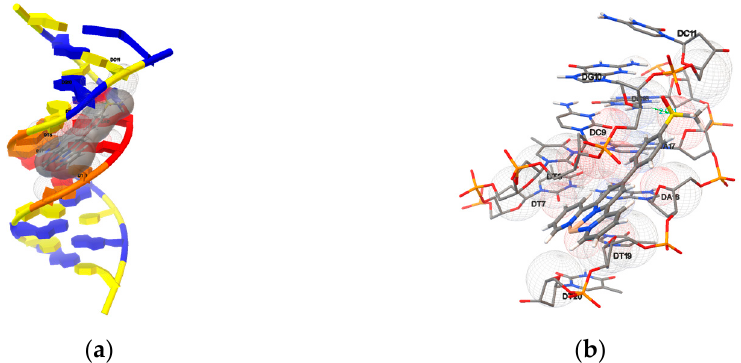
Figure 9. ( a ) The most favorable orientation and ( b ) enlarged view of compound 2f bound with the minor groove of the B-DNA (PDB ID: 1BNA). The formed hydrogen bond and distance have been marked. Table 2. The calculated free energy of binding of compounds 1a – 1c and 2a – 2h with B-DNA (1BNA), oligonucleotide (4JD8M) and DNA-Topo I complex (1SC7).